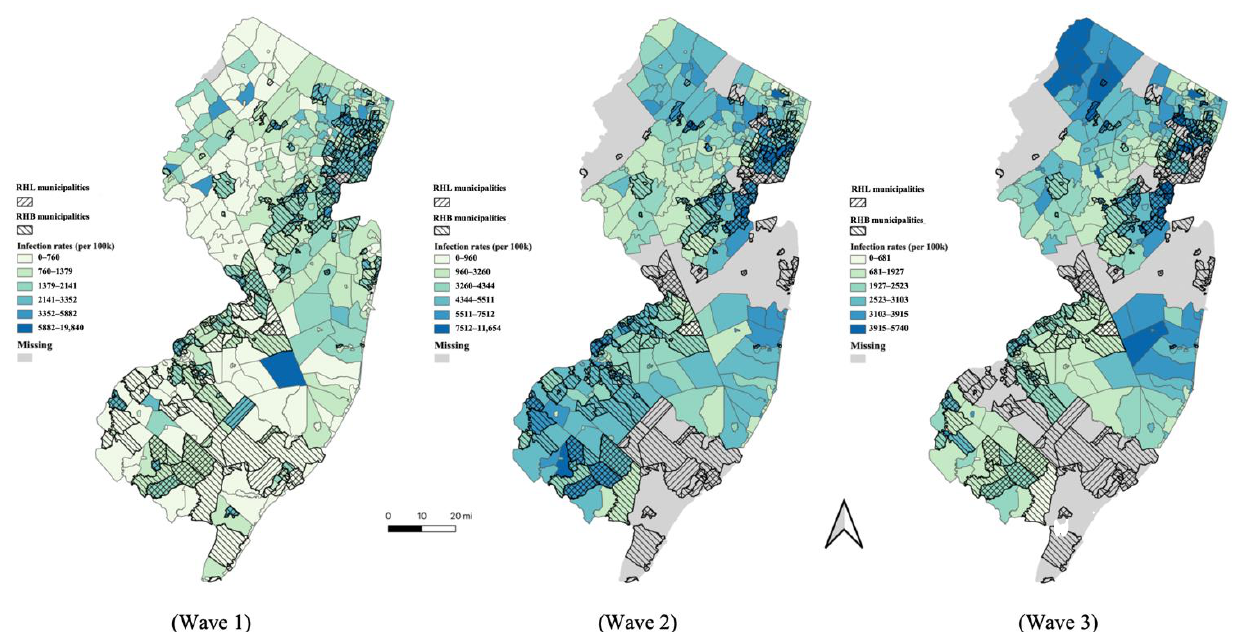
Figure 2. Distributions of COVID-19 within New Jersey municipalities characterized as Relatively High Percentages of Latinx Residents (RHL) and Relatively High Percentages of Black Residents (RHB) across three peaks in infection rates during the first 17 months of the pandemic.